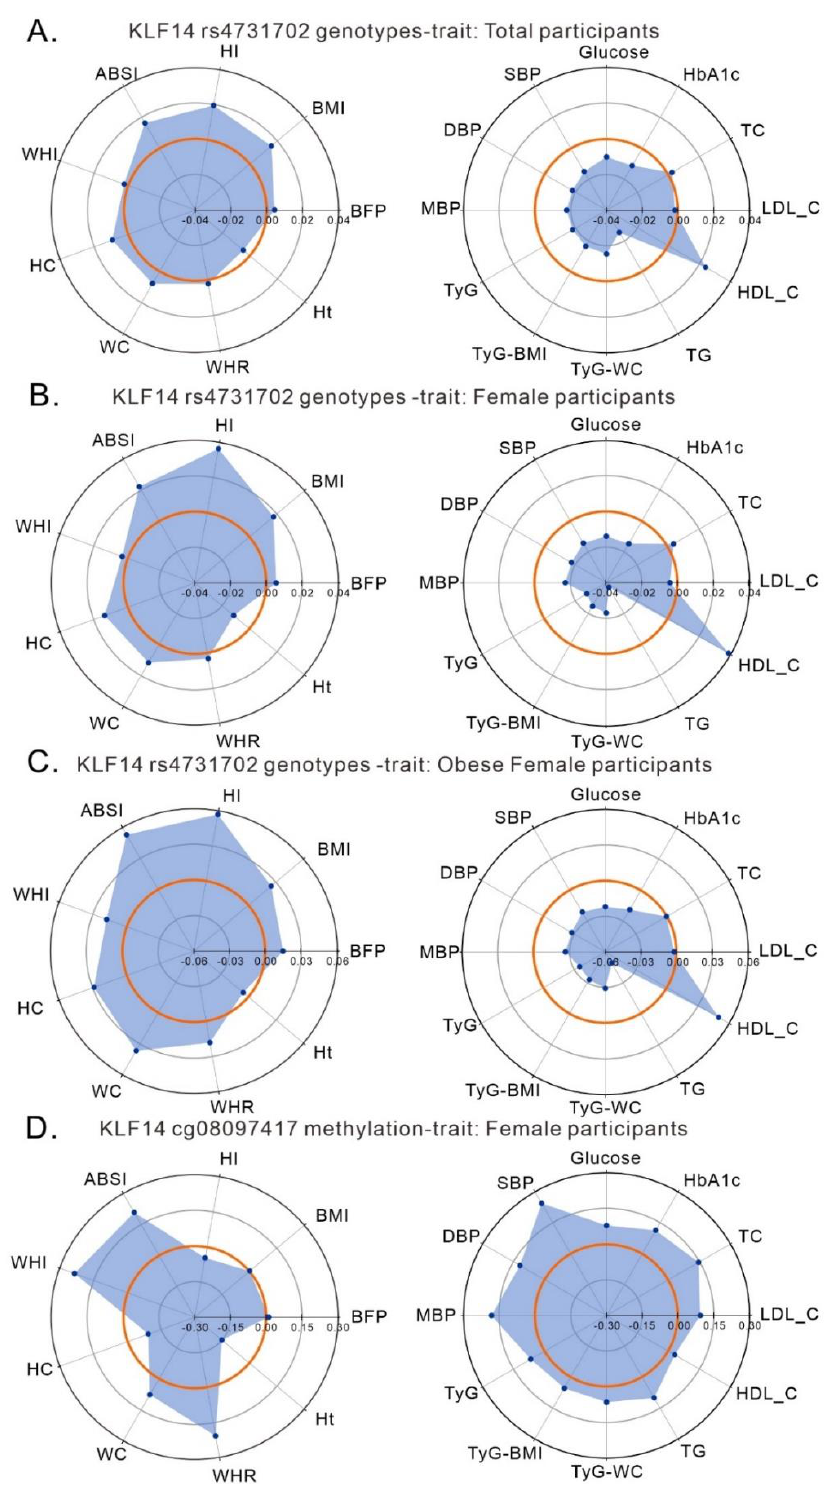
Figure 5. KLF14 rs4731702 genotype ( A – C ) and KLF14 promoter methylation site cg08097417 ( D ) and their associations with body shape indices (left panel) and metabolic traits (right panel) in the Taiwan Biobank population. Standardized coefficients (beta) are shown in Radar plots for total participants ( A ), female participants ( B , D ), and obese female participants ( C ). The middle of the three concentric circles is labeled “0,” representing no association between the KLF14 variant and methylation status and trait. Points falling outside the middle octagon or dodecagon represent positive variant–trait or methylation–trait associations, whereas those inside it represent negative variant–trait or methylation–trait